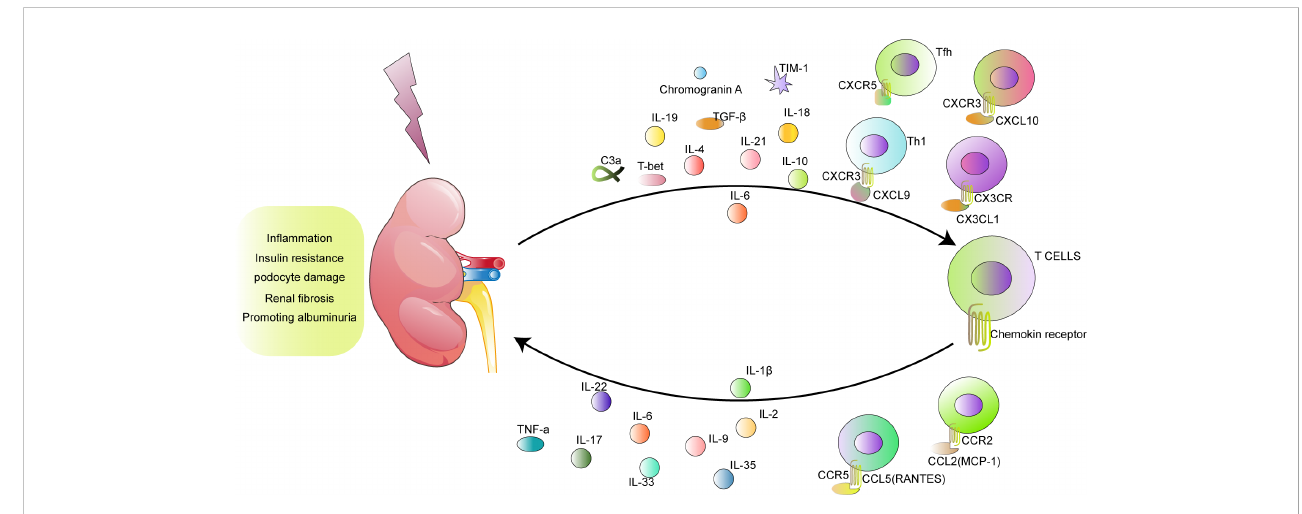
FIGURE 1 The model of T cells and their products participating in